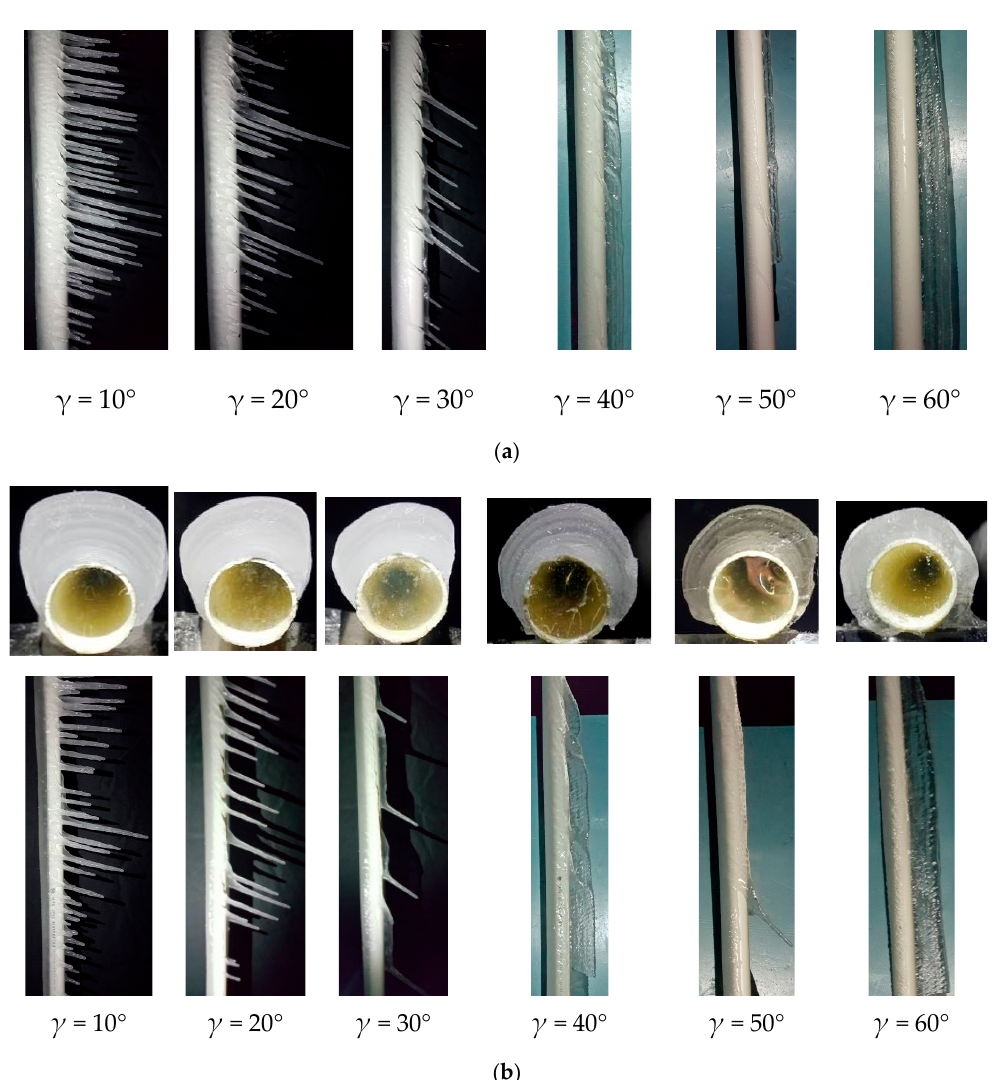
Figure 16. Profile and lateral views of ice accreted cylinder for various γ ( N = 100) : ( a ) D = 50 mm, ( b ) D = 25 mm.